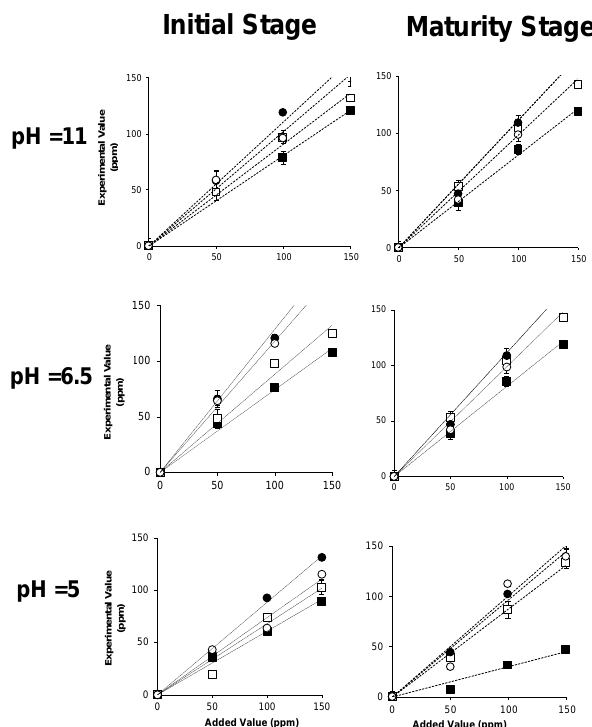
sponding to the β -glucosidase, acid and alkaline